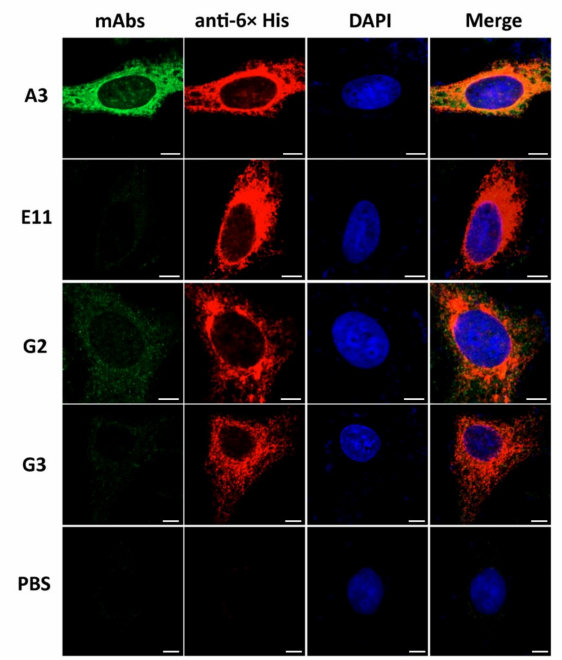
Figure 3. Co-localization of the rS1-specific-mAbs to PEDV S1 overexpressed in HeLa cells as determined by confocal microscopy. HeLa cells transfected with S1 -pTriEx 1.1 recombinant